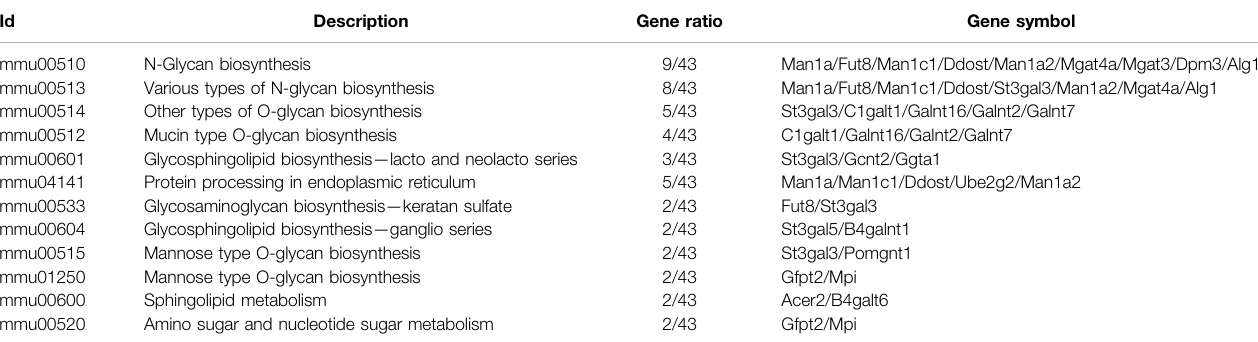
TABLE 1 | KEGG pathway analysis was performed by mapping N-type glycosylated genes in GO enrichment. Id Description Gene ratio Gene